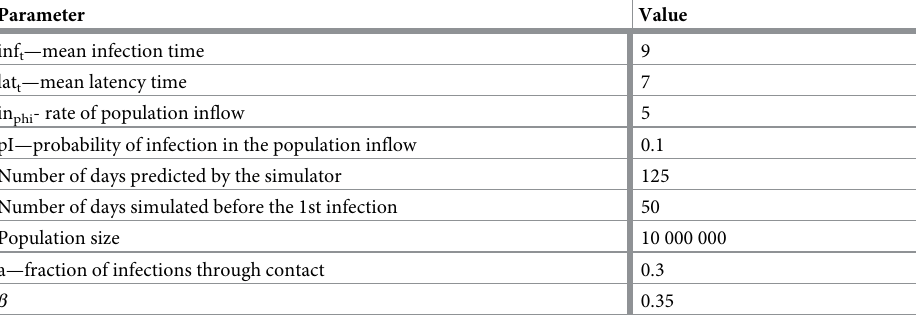
Table 1. The model parameters used for